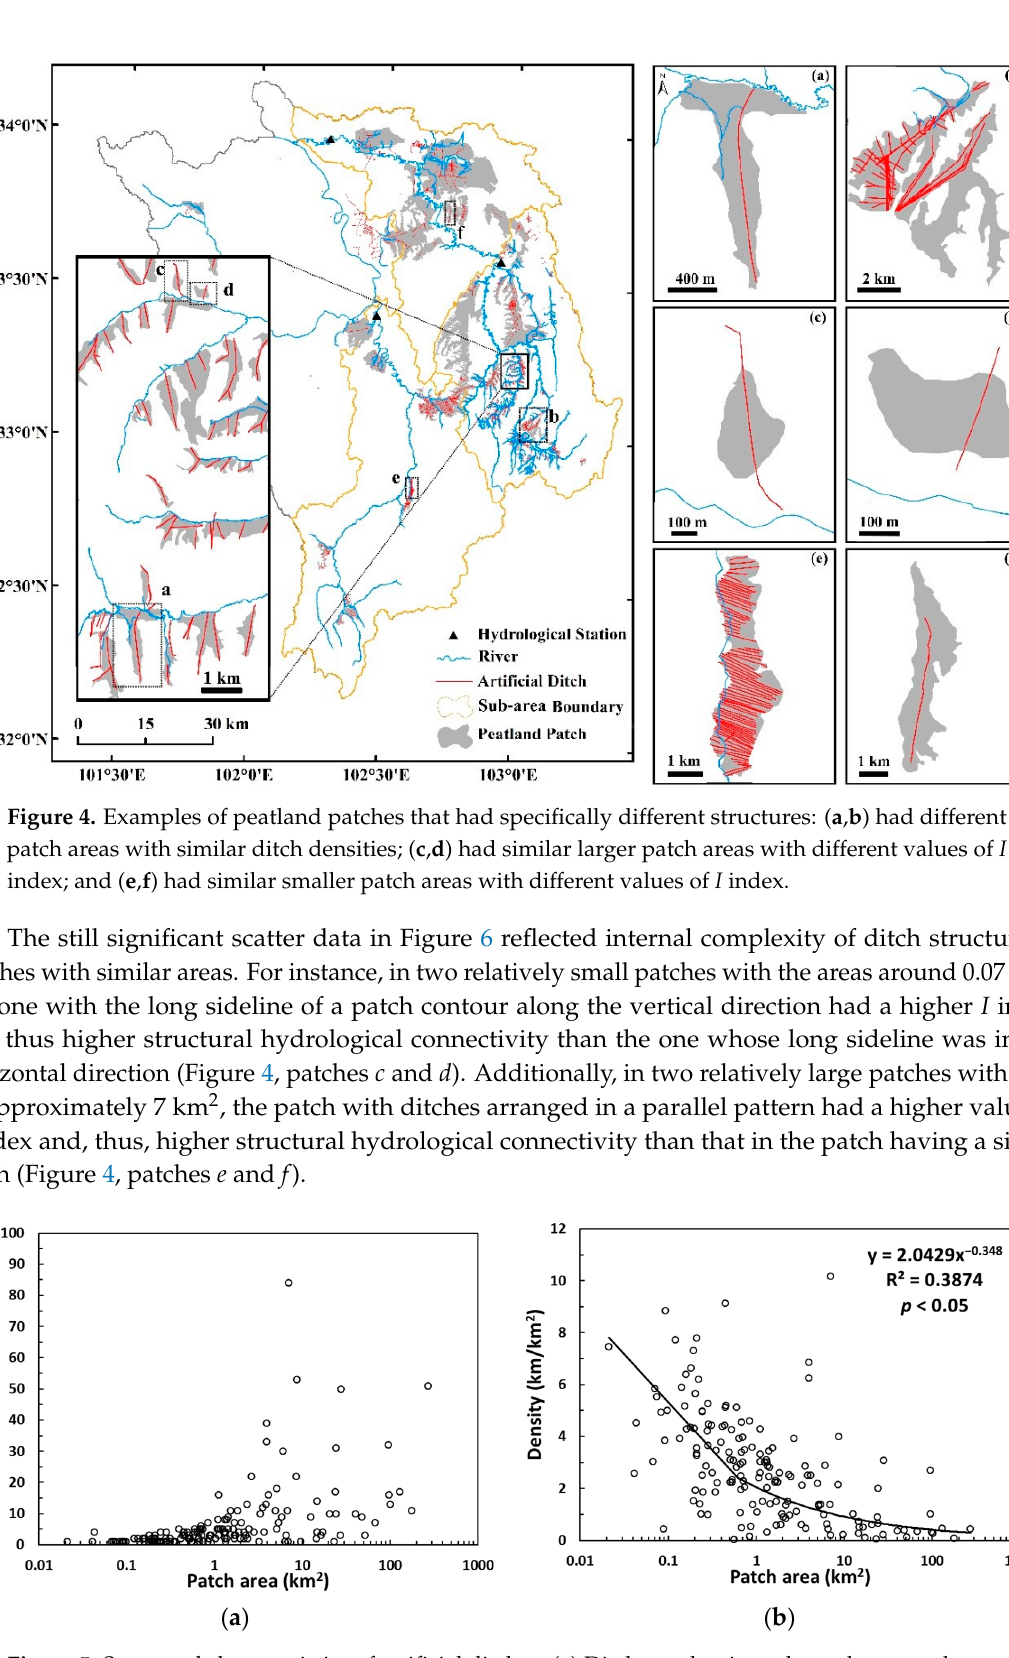
Figure 5. Structural characteristics of artificial ditches. ( a ) Ditch number in each patch vs. patch area; ( b ) ditch density within each patch vs. patch area.